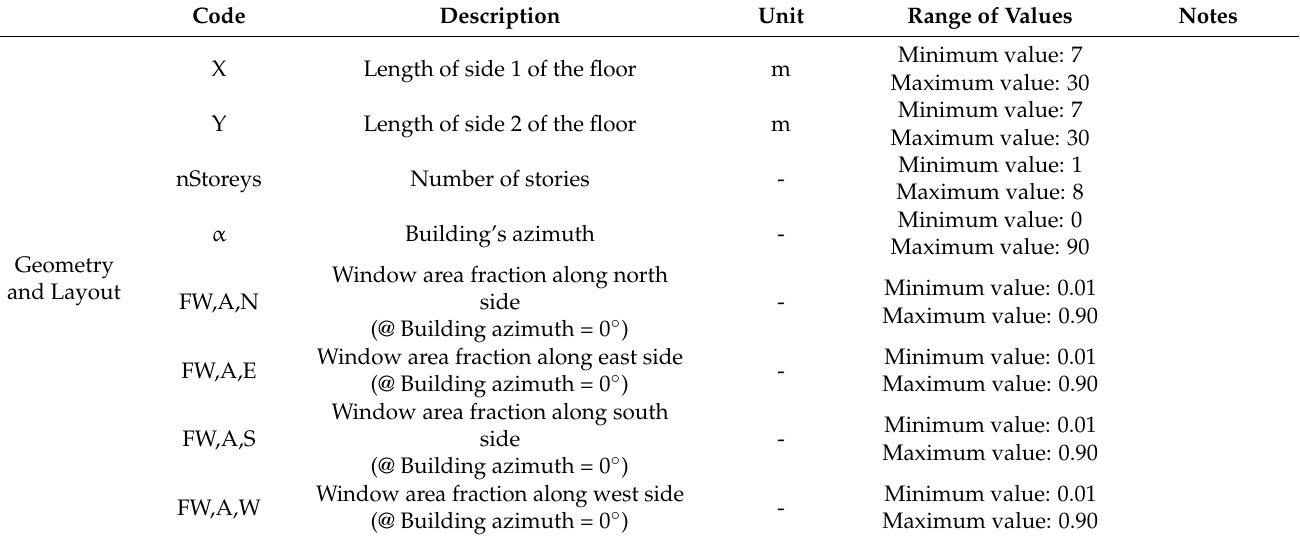
Table 1. Range of values considered in the input